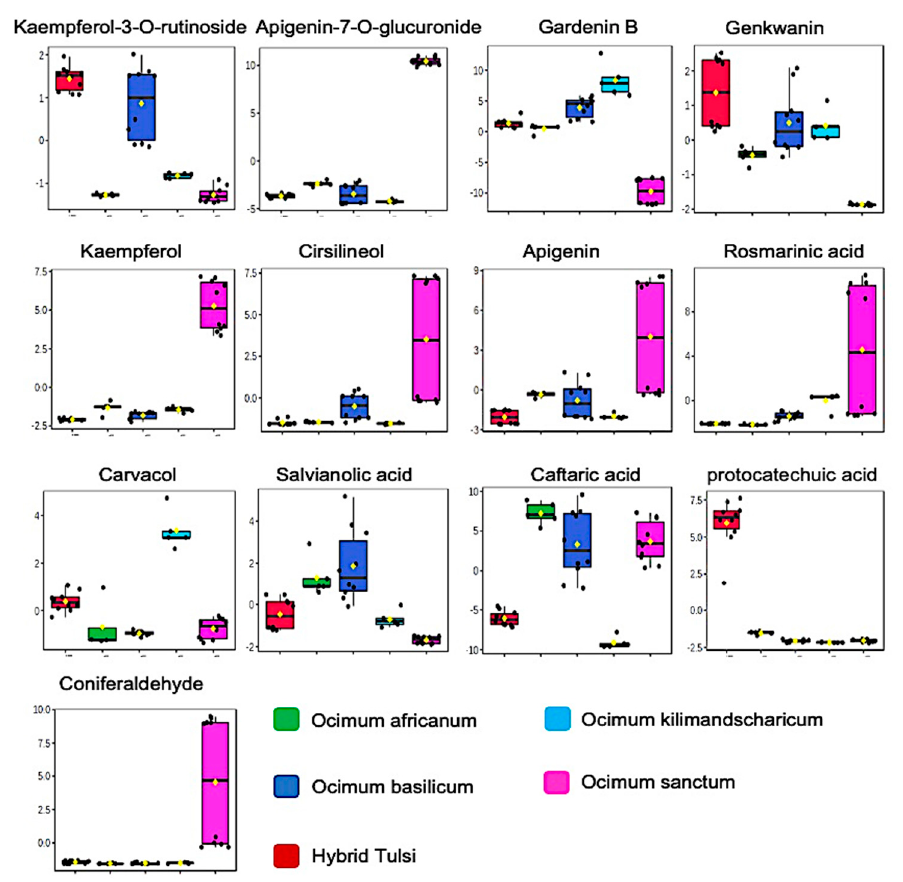
Figure 3. Box plot for discriminatory metabolite markers, identifying the differences in five different Ocimum species, namely, O. sanctum , O. basilicum , O. kilimandscharicum , Hybrid Tulsi, and O. africanum. Normalised intensities are presented in the y -axis.